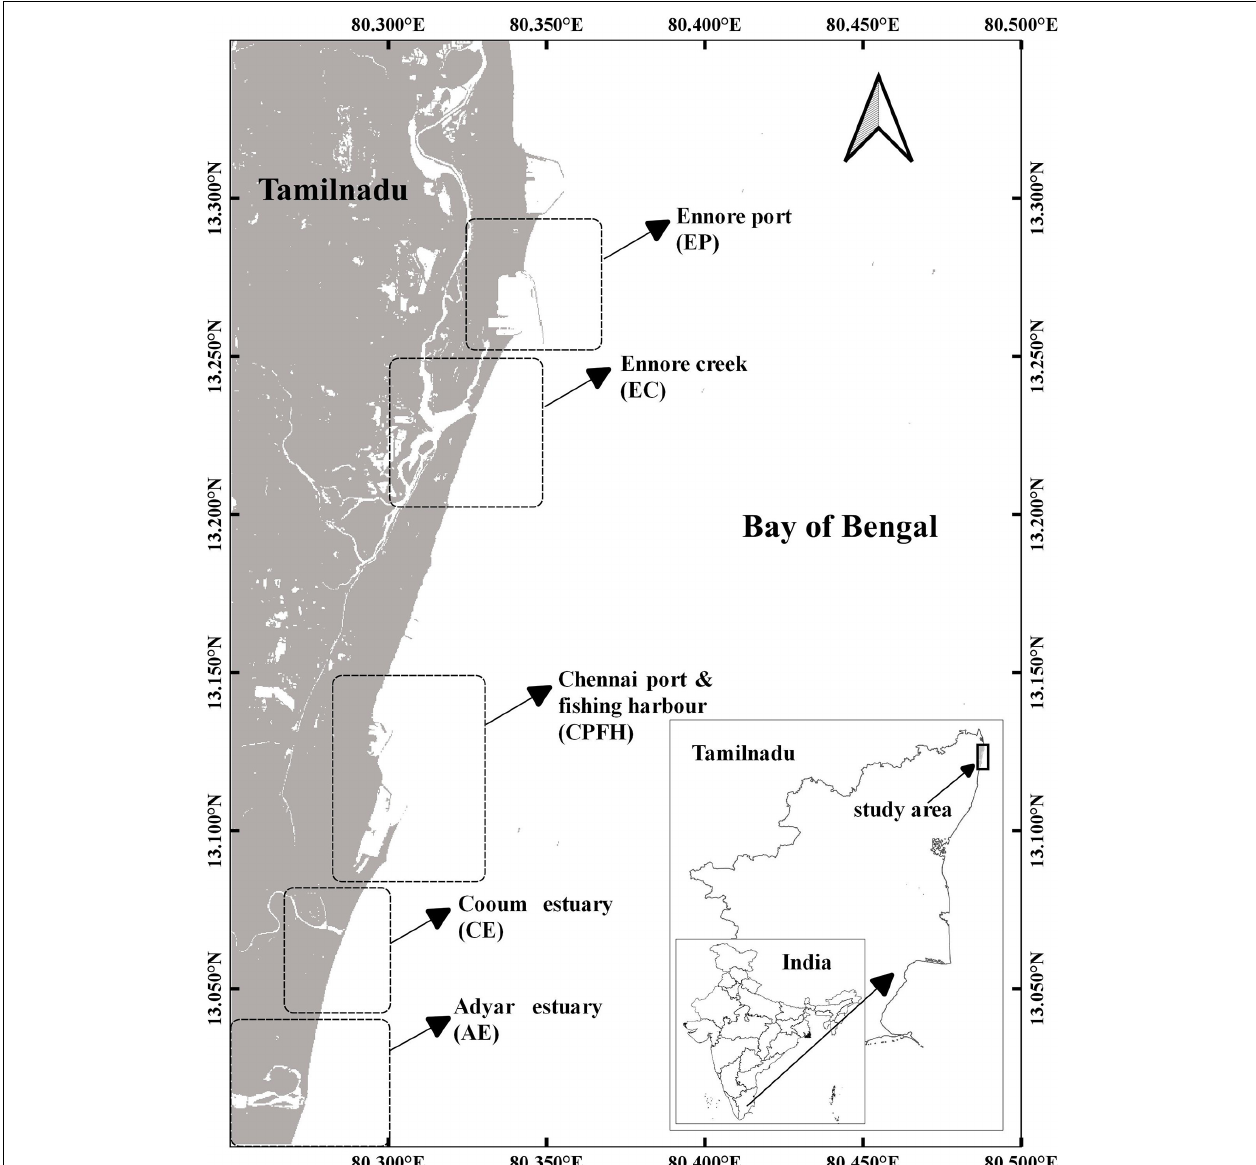
FIGURE 1 | Study area and prominent regions prone to marine pollution along the Chennai coast.